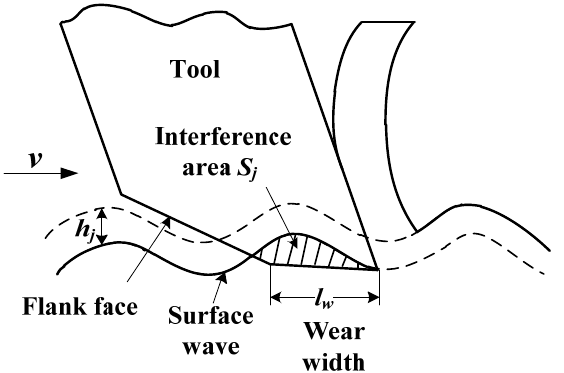
Figure 2. Interference between flank face and machined surface of the workpiece.